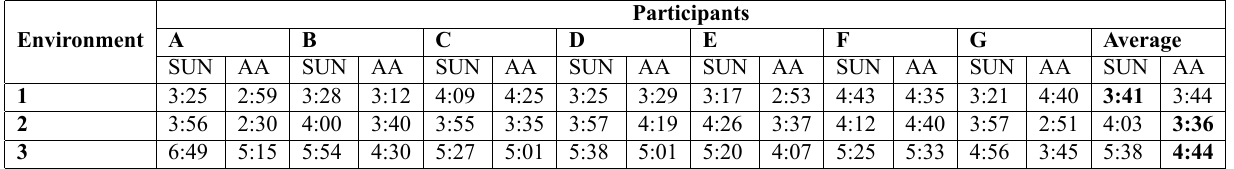
Table 2: The times taken for subjects to scan and annotate the environments shown in Figure A1. For SUN trials, the time required to scan and time required to annotate are summed together. All times are given in minutes and seconds. result their Augmented Annotations trial times differed greatly.